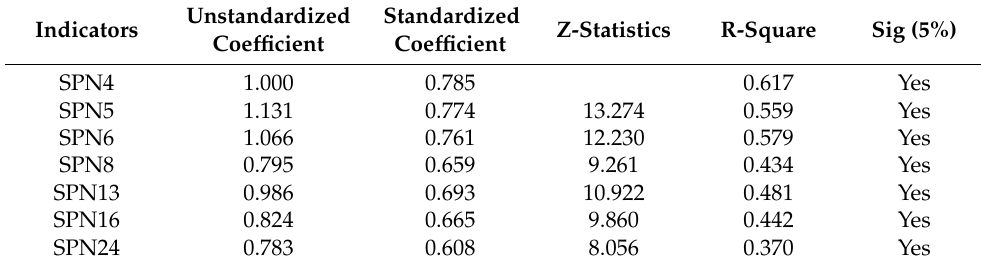
Table 11. Factor loadings and Z-statistics of SPN.